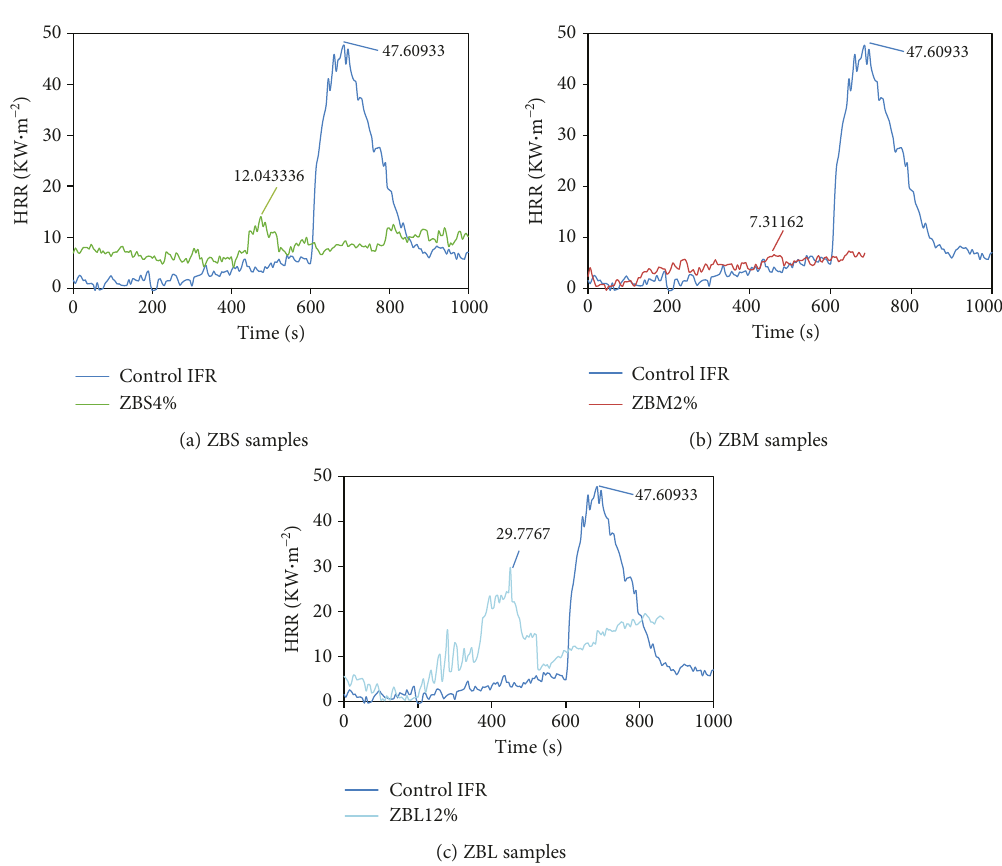
Figure 3: Heat release rate of wood treated with IFR/ZB